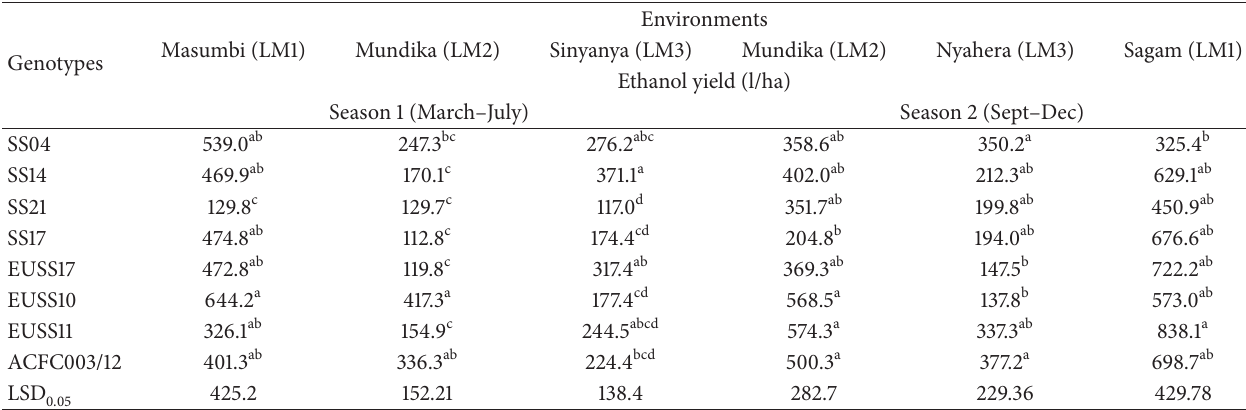
Table 7: Ethanol yield (l/ha) of sweet sorghum genotypes across